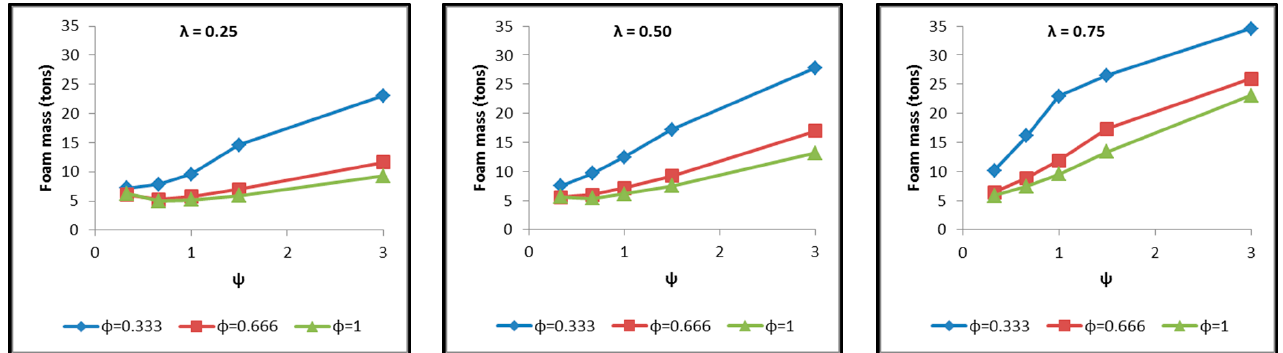
Figure 19. Distribution of the required insulating material mass for maintaining the boil-off rate at 0.1%/hr as a function of the ratios λ , φ and ψ .